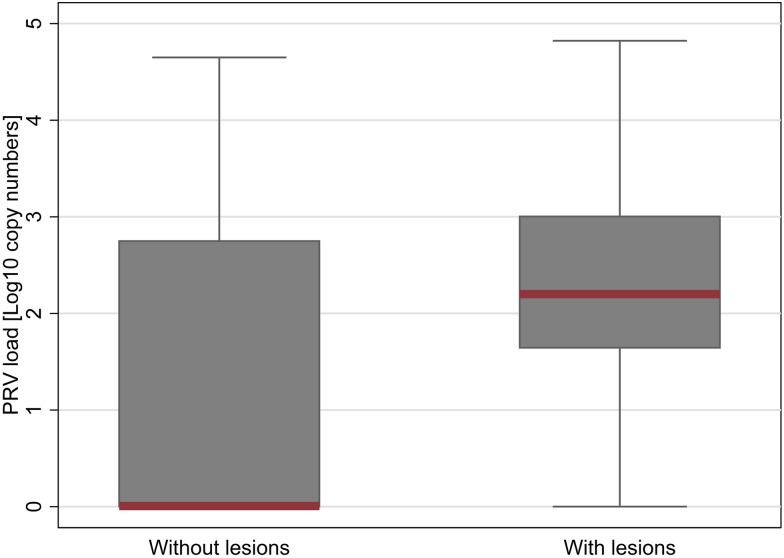
PRV load in association with heart lesions.Box plots of PRV load in heart tissue of fish analysed on the basis of the presence of heart lesions. Median of PRV load is highlighted in red. PRV is presented as copy numbers + 1 normalized into a base 10 logarithmic scale. Presence of lesions is defined by a histopathological score in myocardium and epicardium equal or higher than 1 in a scale of 0–6.